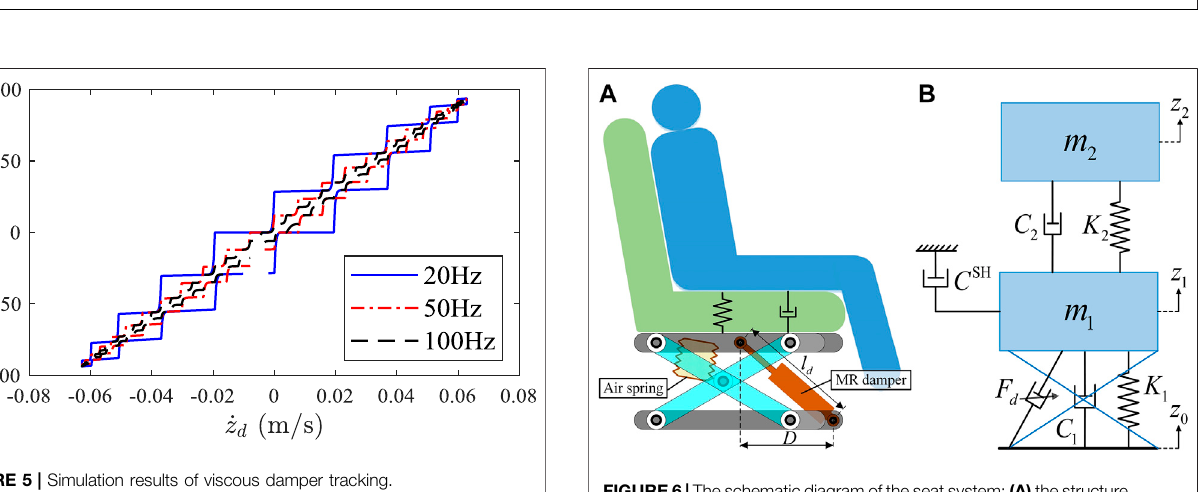
FIGURE 4 | Parameter fi t curve: (A) nonlinear fi tting of parameter c ; (B) nonlinear fi tting of parameter f c ; (C) linear fi tting of parameter c ; (D) linear fi tting of parameter f c .